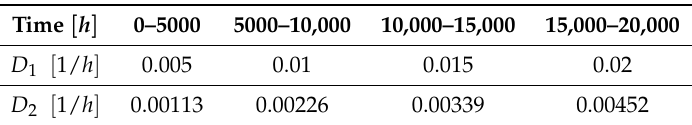
Table 3. Values of D 1 and D 2